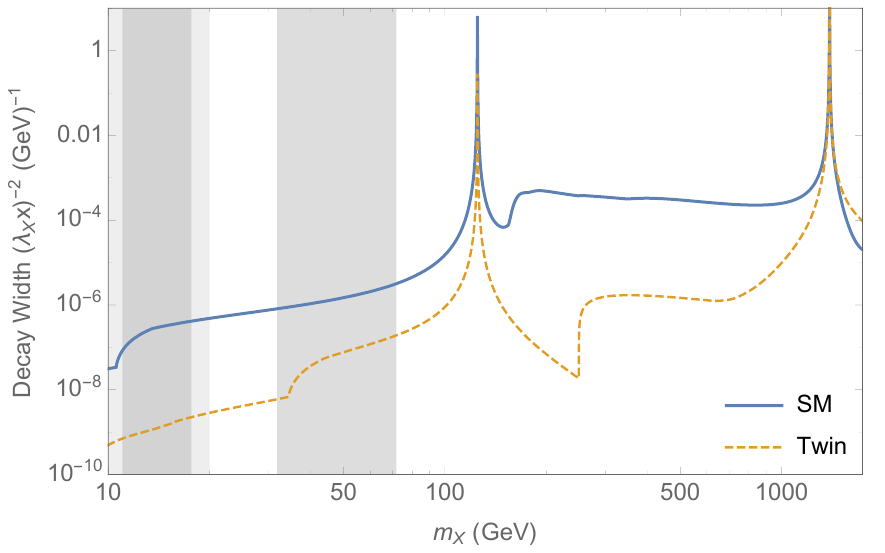
Figure 5 . The partial widths of the X into the SM (solid blue line) and twin sector (dashed orange) for f=v = 3 in units of ( (cid:21) x x ) 2 . The light gray bands indicate regions of QCD-related uncertainty in the SM calculation, while the darker gray bands indicate the corresponding regions of uncertainty for the twin calculation.